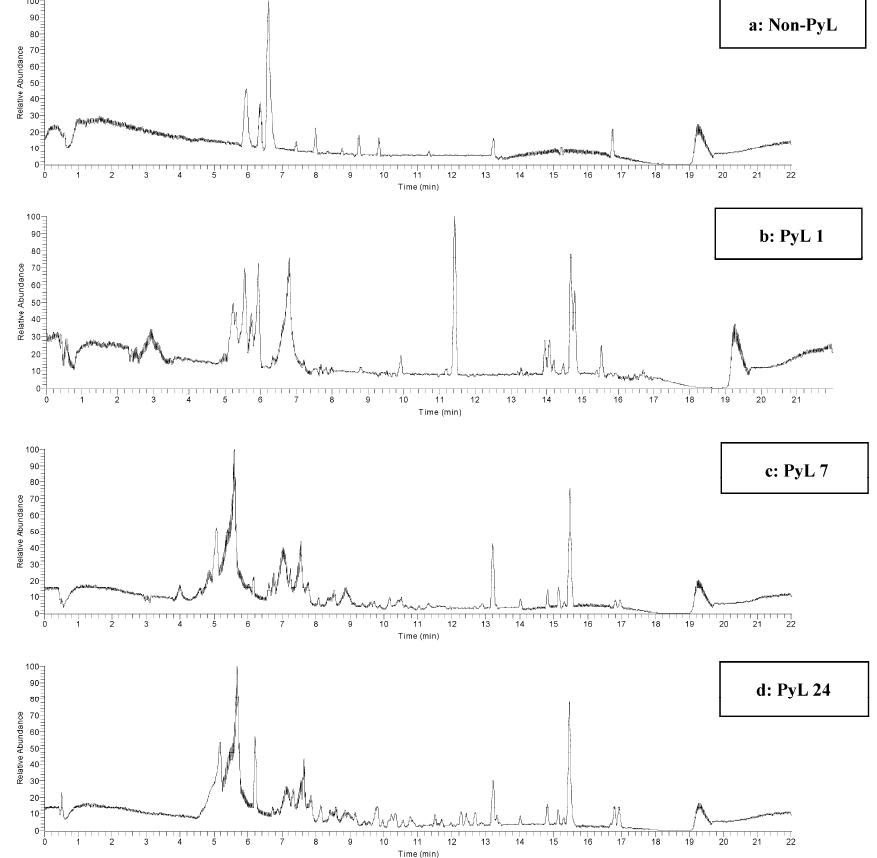
Figure 1. Selected HPLC-MS chromatograms (base peak) obtained using LTQ-ORBITRAP (Discovery) in the positive mode: ( a ) non-PyL; ( b ) PyL 1; ( c ) PyL 7; and ( d ) PyL 24, revealing the diversity of separated compounds from selected samples.